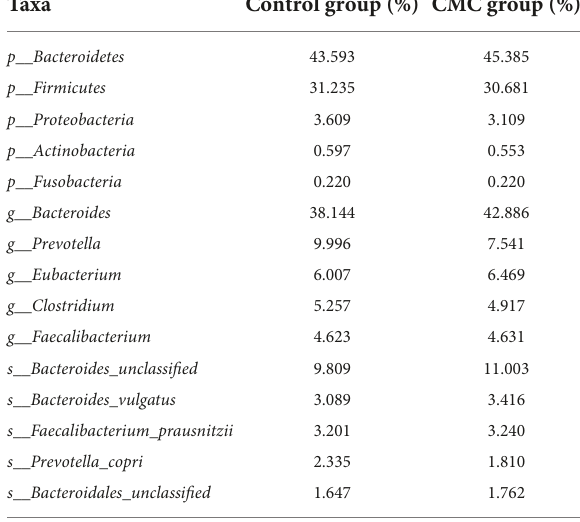
TABLE 3 Dominated taxa in two